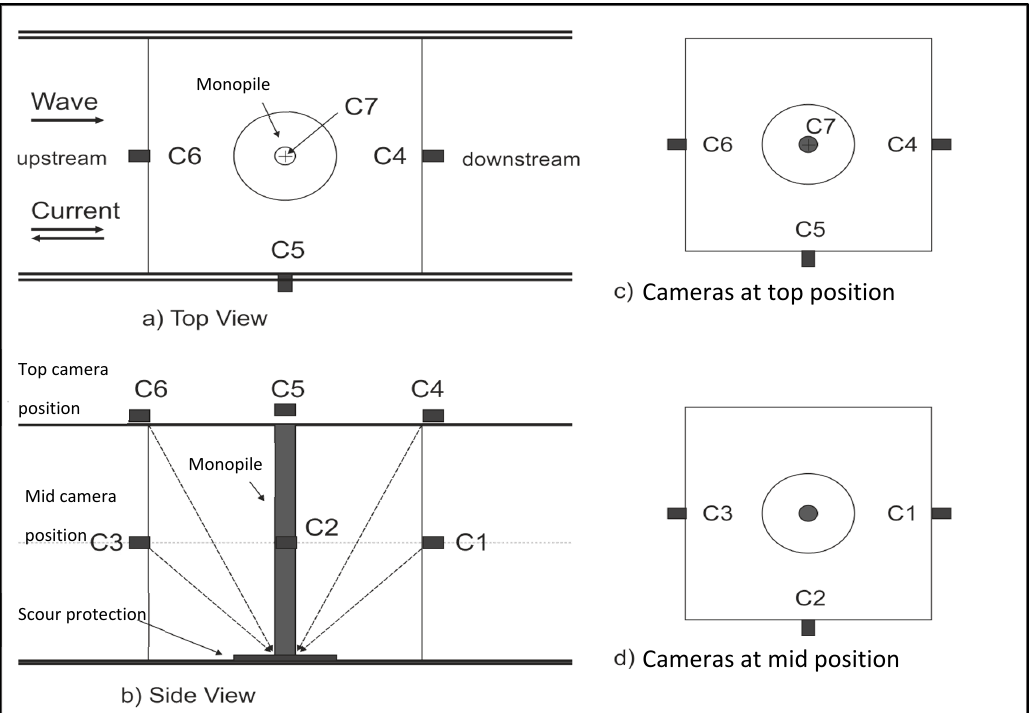
Figure 9. Camera position for photographic material recording.